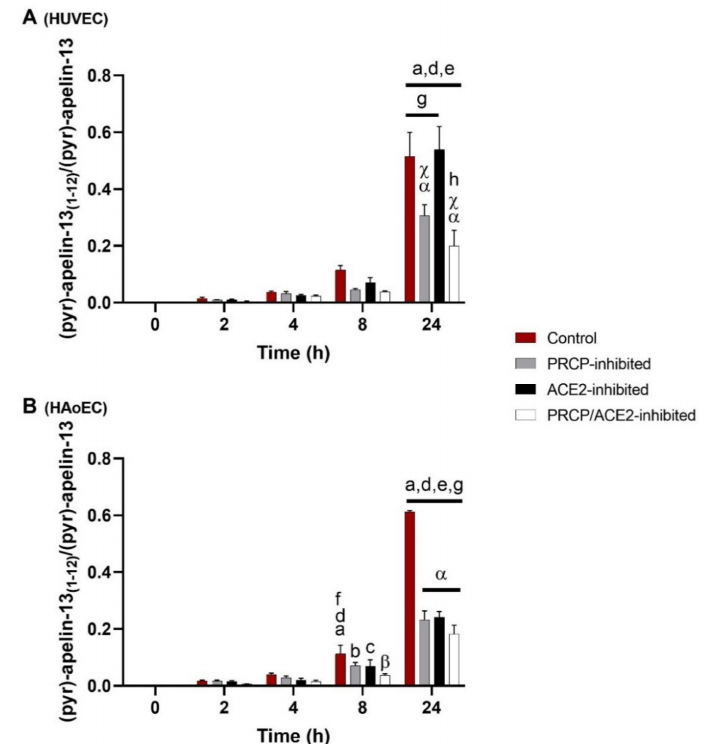
Figure 1. Cleavage of (pyr)-apelin-13 to (pyr)-apelin-13 (1–12) is PRCP-dependent in HUVEC and PRCP- and ACE2-dependent in HAoEC. C-terminal cleavage of (pyr)-apelin-13 to (pyr)-apelin- 13 (1–12) in HUVEC ( A ) and HAoEC ( B ) ( n = 4 per group), expressed as the ratio of the peak intensity of (pyr)-apelin-13 (1–12) to the peak intensity of (pyr)-apelin-13 measured in the supernatant. Two-way ANOVA analysis revealed a significant interaction between the effects of treatment duration and treatment option on the ratio of the peak intensities ( p < 0.001) in both types of endothelial cells. Results are reported as mean ± SEM. Significant p-values are indicated on the graph (a: different from 0 h, p < 0.001; b: different from 0 h, p < 0.01; c: different from 0 h, p < 0.05; d: different from 2 h, p < 0.001; e: different from 4 h, p < 0.001; f: different from 4 h, p < 0.01; g: different from 8 h, p < 0.001; h: different from 8 h, p < 0.01; α : different from control, p < 0.001; β : different from control, p < 0.01; χ : different from ACE2-inhibited group, p < 0.001; within treatment group and time point group